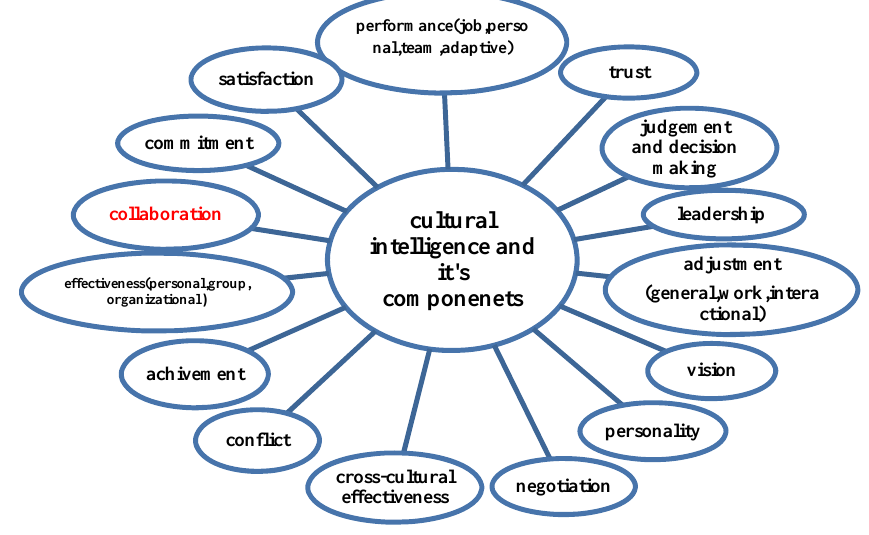
Fig. 3. Research map of the cultural intelligence